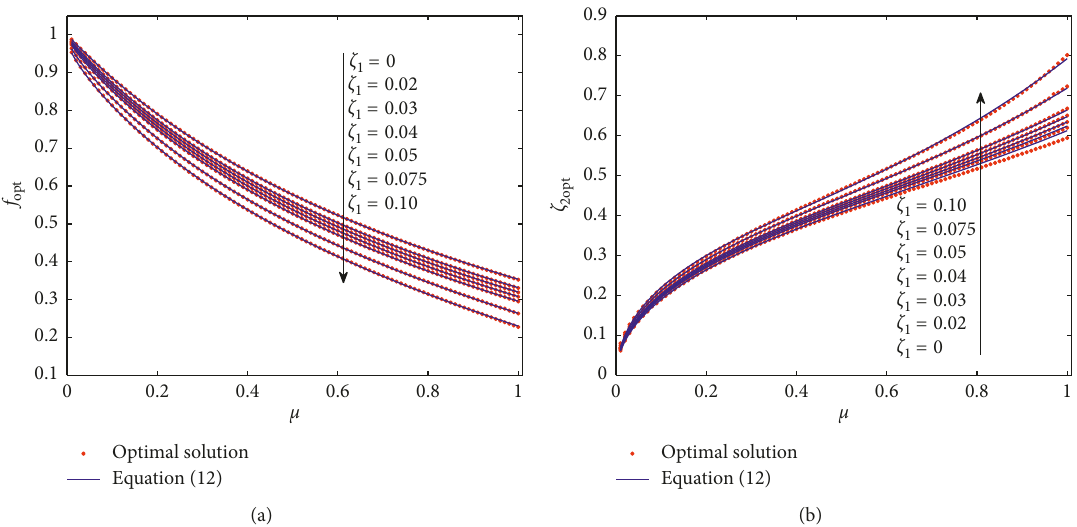
Figure 4: The relationship between the revised fitting formula value and the actual optimal value with the TMD mass ratio and the damping ratio of the main structure under the excitation of harmonic load. (a) Optimal frequency ratio. (b) Optimal damping ratio.